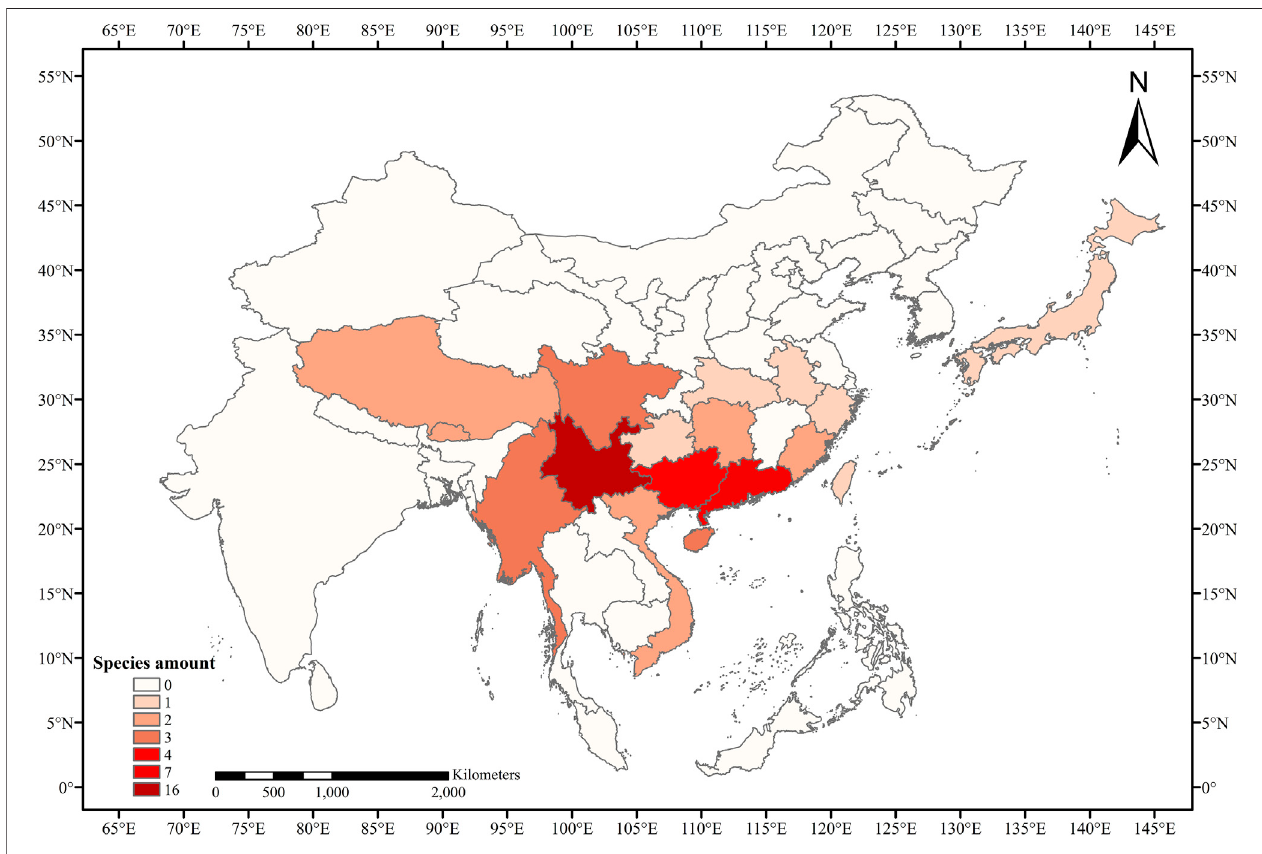
FIGURE 1 | Species diversity heat map of Eriobotrya and Rhaphiolepis in this